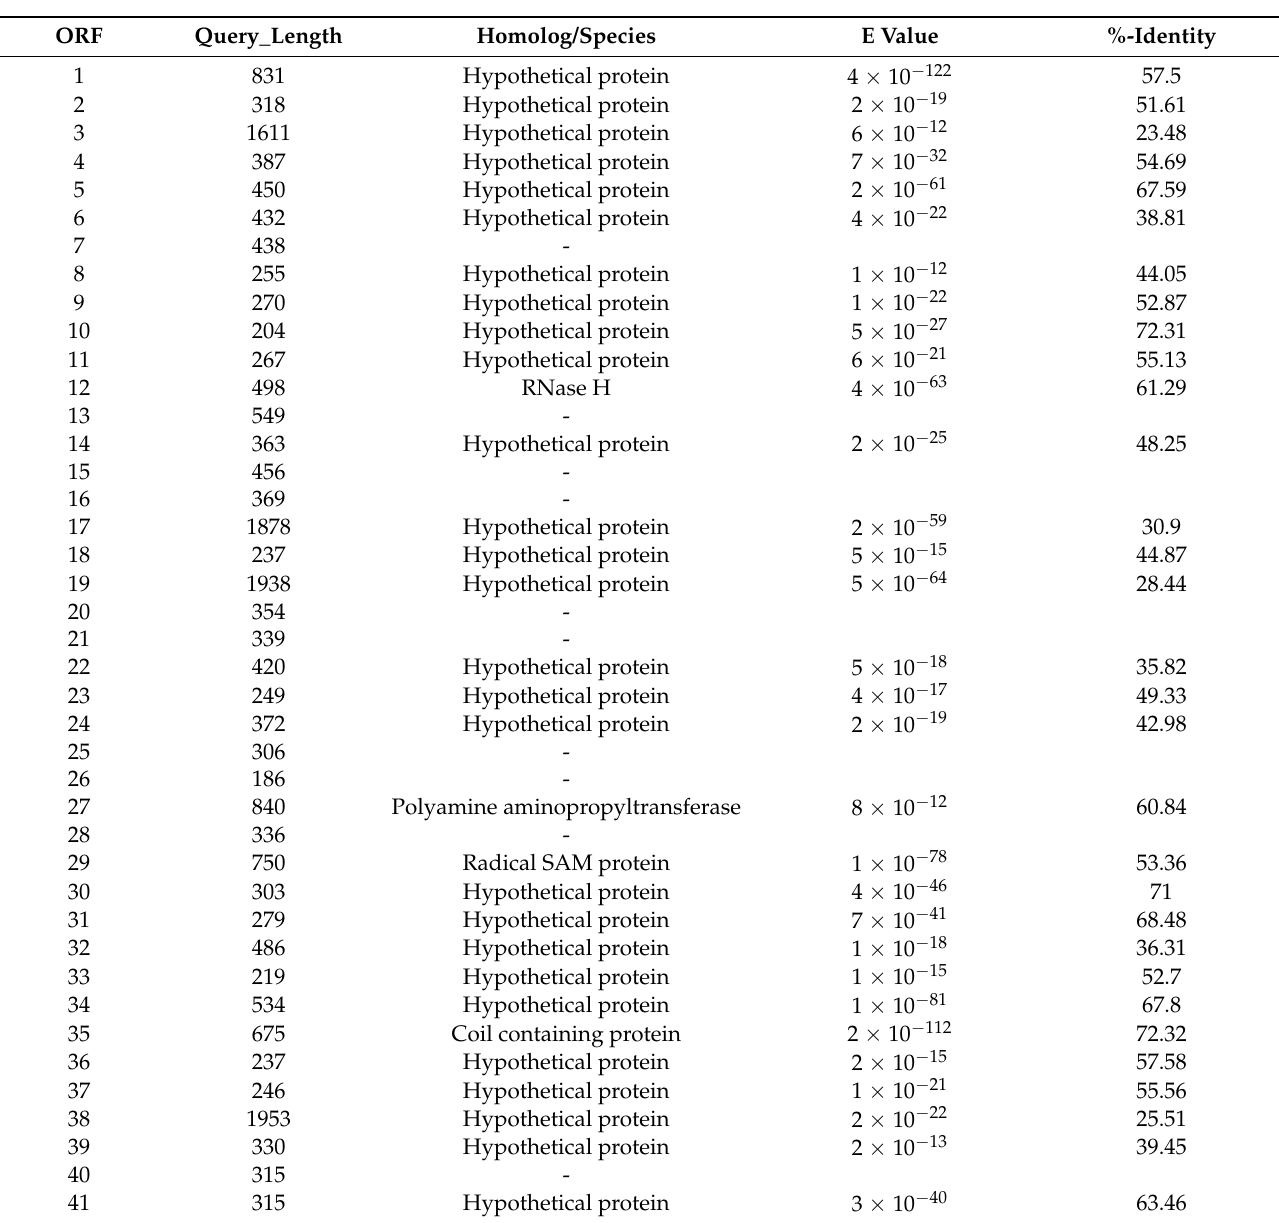
Table 2. The detected ORFs of V-YDF132, including the length and the putative